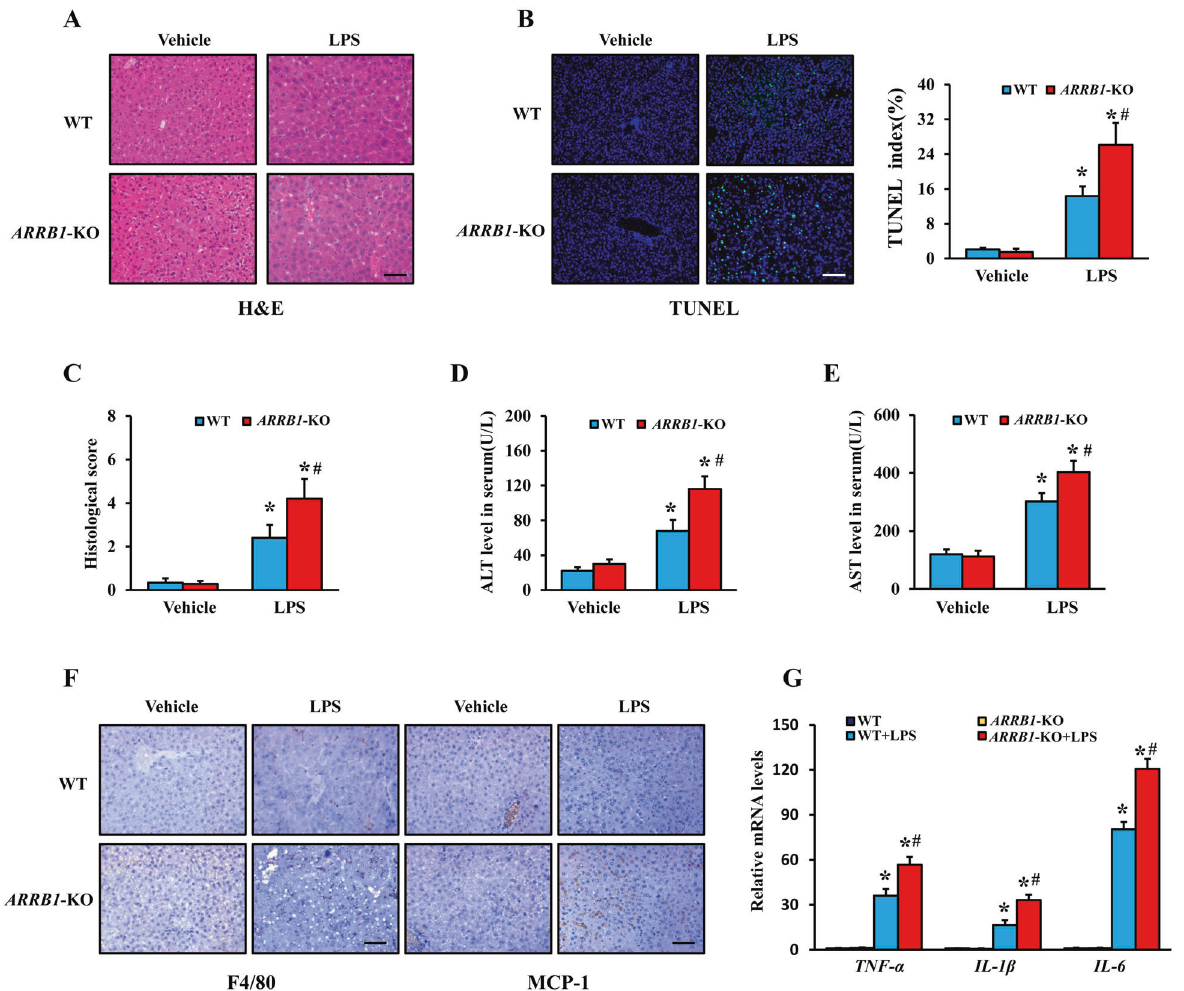
Fig. 3 ARRB1 de fi ciency aggravated LPS-induced acute liver injury and activation of liver macrophages. A Representative H&E staining of livers in vehicle- and LPS-induced ARRB1 wild-type (WT) and ARRB1 knockout (KO) mice (scale bar: 50 μ m). B TUNEL staining of livers in vehicle- and LPS-induced WT and ARRB1 -KO mice (scale bar: 50 μ m), and the positive TUNEL index was scored. C Liver histology scoring in vehicle- and LPS-induced WT and ARRB1 -KO mice. D , E Serum ALT and AST levels in vehicle- and LPS-induced WT and ARRB1 -KO mice. F F4/80 and MCP-1 staining of livers in vehicle- and LPS-induced WT and ARRB1 -KO mice (scale bar: 50 μ m), and the positive F4/80 and MCP-1 indexes were scored. G TNF- α , IL-1 β , and IL-6 mRNA levels in vehicle- and LPS-induced WT and ARRB1 -KO mouse liver tissues were analyzed by real-time PCR. All values are the mean ± SD ( n = 6 in each group). * P < 0.05 compared with the respective vehicle treatment; # P < 0.05 compared with LPS- induced WT mice by Student ’ s t